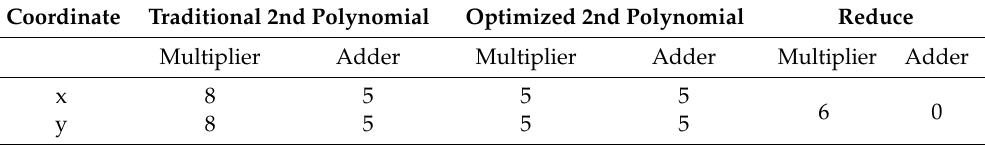
Table 1. The number of multiplier and adder comparison with Equations (1), (2), (14), and (15). Coordinate Traditional 2nd Polynomial Optimized 2nd Polynomial Multiplier